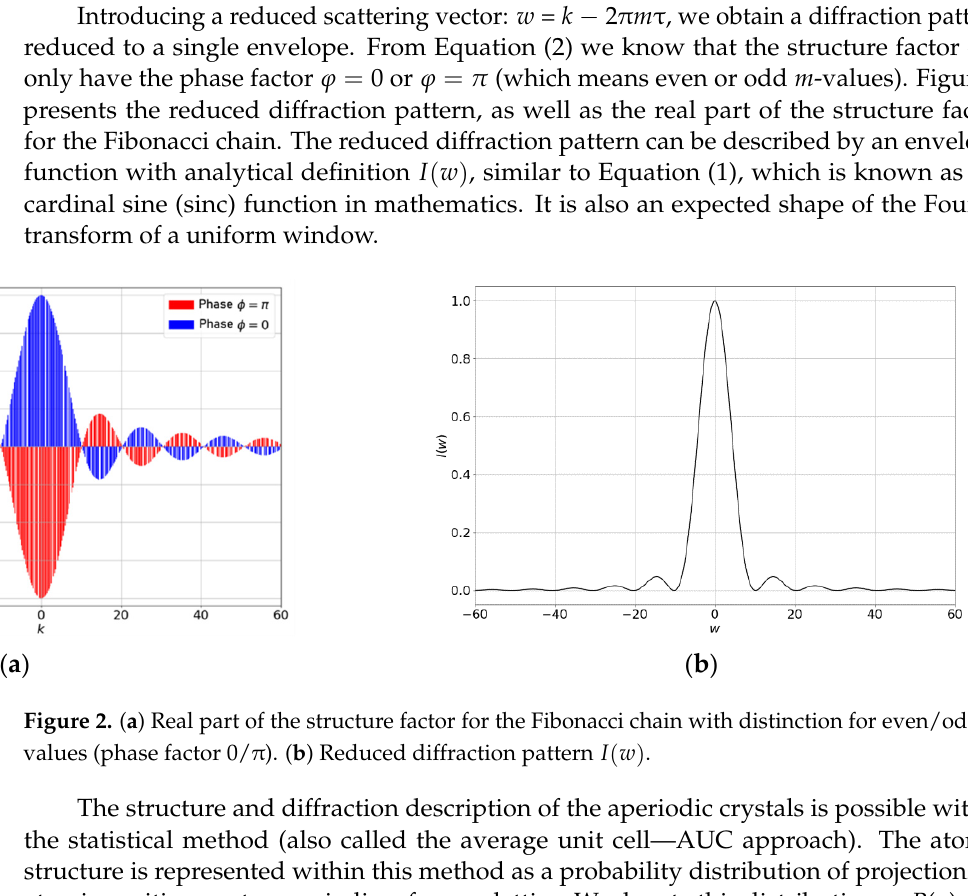
Figure 1. ( a ) Diffraction pattern of the Fibonacci chain ( 𝑘 (cid:2868) = 2𝜋𝜏/(𝜏 (cid:2870) + 1) = 2.81 … , indexes 𝑛, 𝑚 ∈ (0,10) , distances L = 𝜏 , S = 1 .). ( b ) Diffraction pattern of the Fibonacci chain with the first five en- velopes marked by different colors.